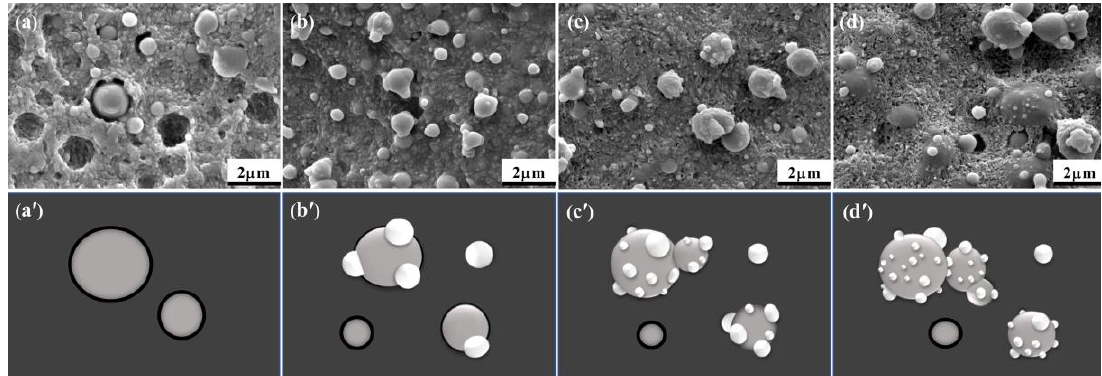
Figure 12. SEM images of the cryofracture surface after being etched and the schematic phase structure of ( a , a’ ) PLA/PCL; ( b , b’ ) PLA/PCL/2; ( c , c’ ) PLA/PCL/8; and ( d , d’ ) PLA/PCL/10.